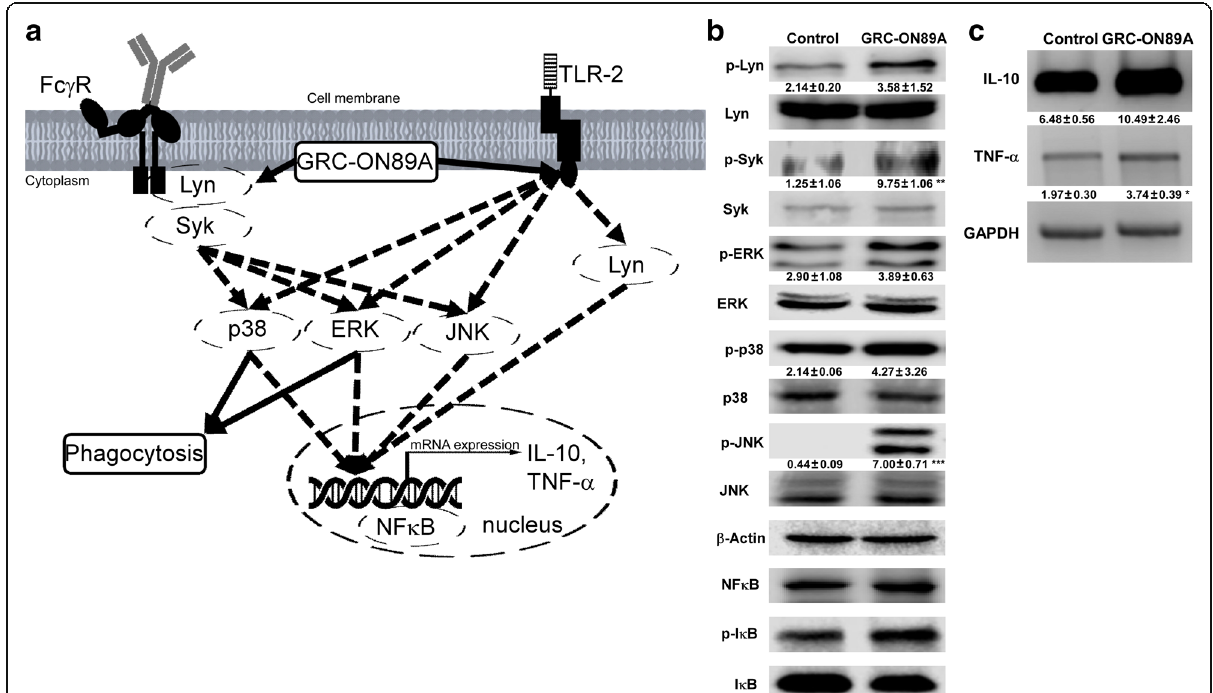
Fig. 5 The effect of GRC-ON89A on the phagocytosis related signaling molecules and on the levels of cytokine mRNA expression. a GRC-ON89A activated Fc γ R signaling pathway. RAW264.7 cells (1 × 10 6 cells/ml) were treated with GRC-ON89A for 1 h. b Total protein lysates were analyzed by Western blot analysis for phosphorylated – and total forms of Lyn, Syk, ERK, p38, JNK, NF κ B, and I κ B. β -Actin was used as the internal control. c The expression level of IL-10 and TNF- α mRNA in RAW 264.7 cells was determined by RT-PCR. Each figure is representative of three independent experiments. Data comparisons between groups were analyzed using Student ’ s t -test and One-way ANOVA with Dunnett ’ s t -test for significance of individual comparisons (* = p < 0.05, ** = p < 0.01, *** = p < 0.001 vs. control